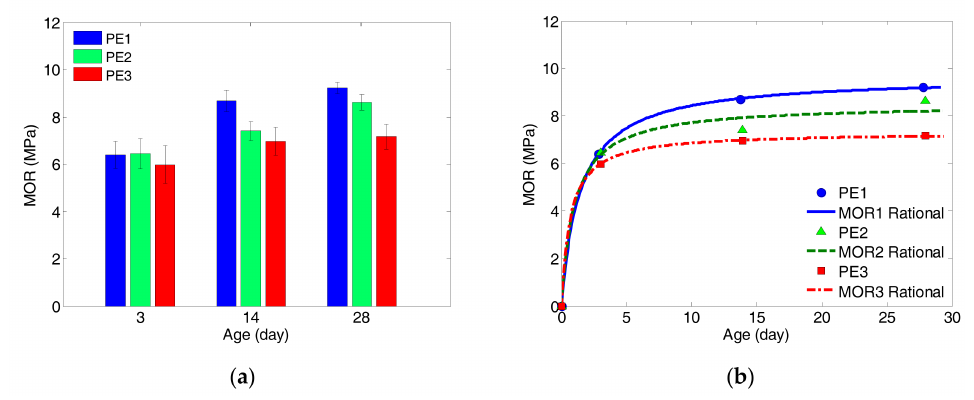
Figure 7. ( a ) Measured average values of MOR with standard deviations; ( b ) regression for measured data by first-order rational function. Table 7. Average MOR with standard deviations, regression coefficients and goodness of fits for Equation